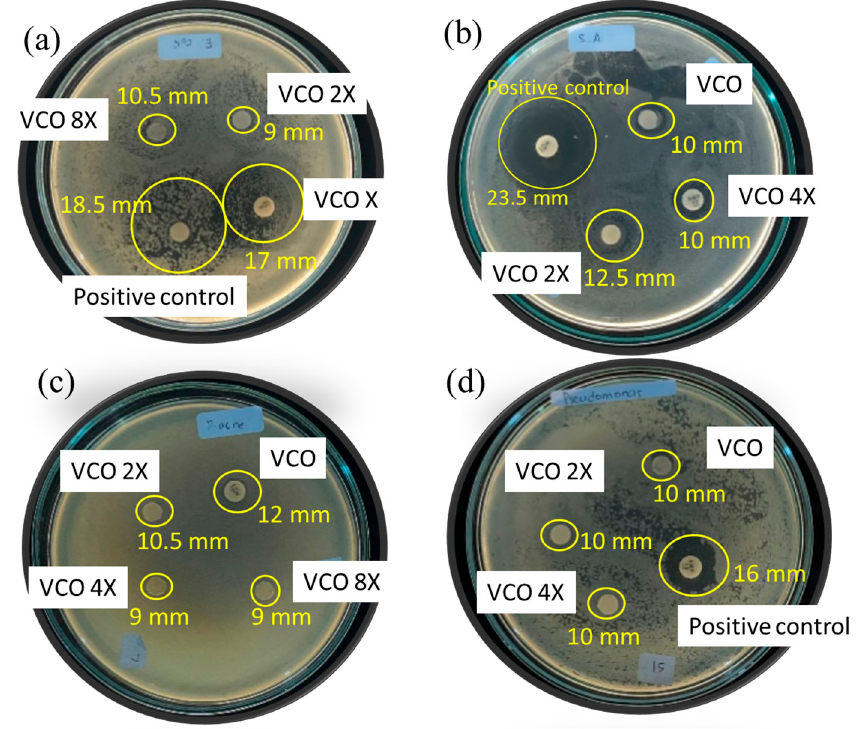
Figure 3. Some images from antibacterial activity test of VCO against ( a ) E. coli , ( b ) S. aureus , ( c ) P. acne , ( d ) P. aeruginosa Table 6. Inhibition zone of antibacterial tests.